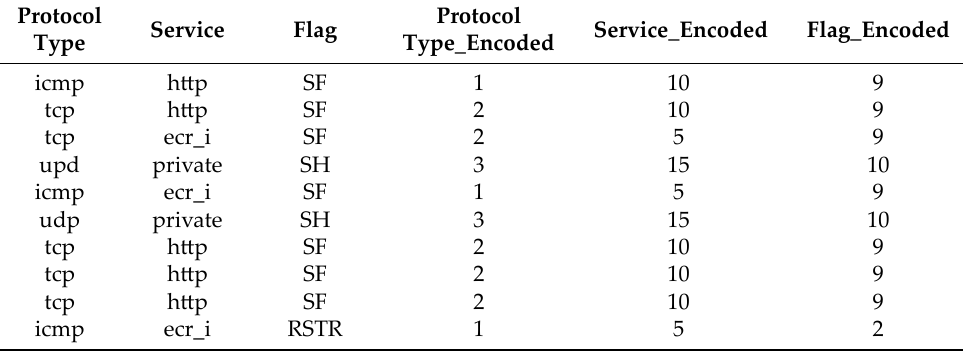
Table 8. Encoding of categorical